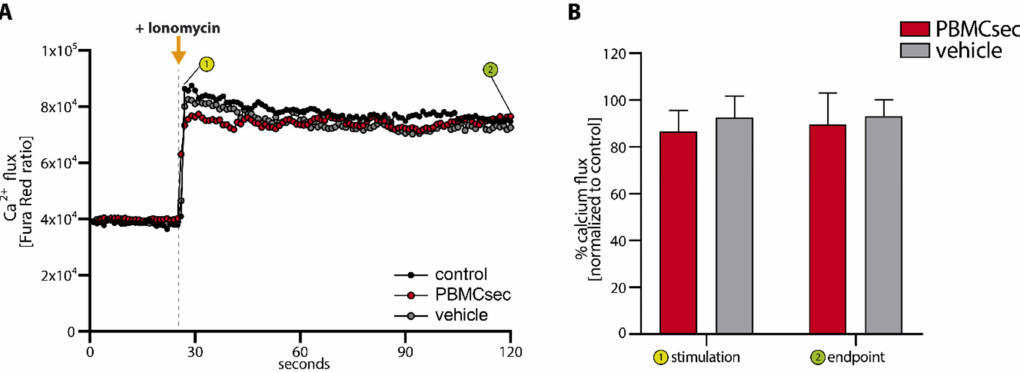
Figure 4. PBMCsec inhibits NET formation without interfering with calcium flux. ( A ) Ratiometric